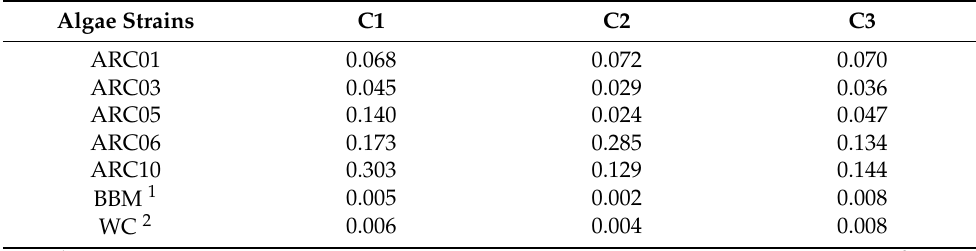
Table 1. Fluorescence intensity (R.U.) of individual FDOM PARAFAC components (C1–C3) in the medium at the beginning of cultivation and at the stationary phase of algae growth. Algae Strains C1 C2 C3